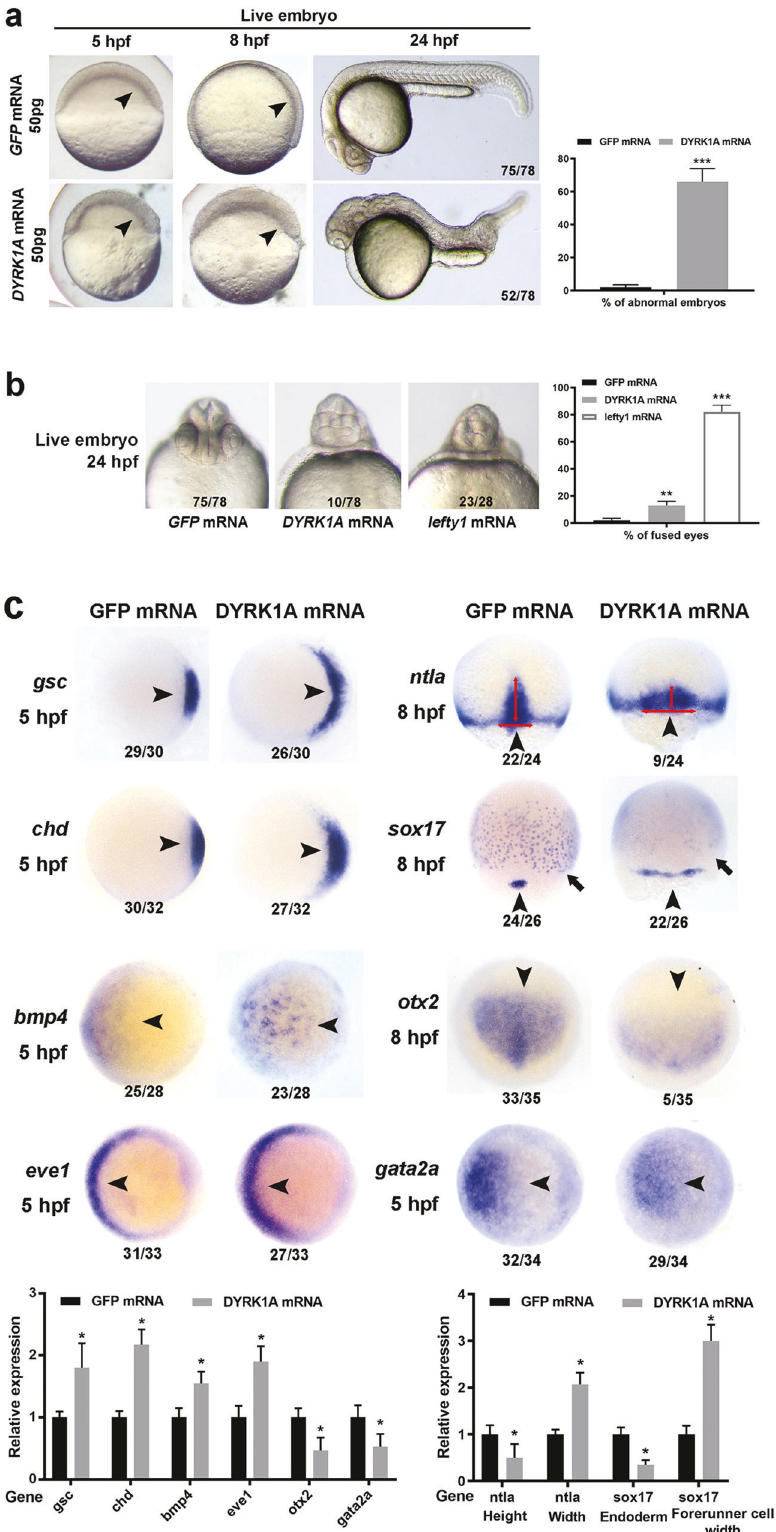
Fig. 1 DYRK1A-overexpressed zebra fi sh embryo model showed shortened/curved body axis. a Morphogenesis of live control (injection with GFP mRNA) and DYRK1A-overexpressed (injection with DYRK1A mRNA) embryos. The arrowheads indicate the dorsal side of the embryo. b Fusion of eyes caused by DYRK1A overexpression resembled the phenotype of lefty1 mRNA injection. c Germ layer marker expression detected by WISH during gastrulation. Orientation: ntla, sox17, and otx2, dorsal views with an animal pole to the top; others, animal-pole views with dorsal to the right. The numbers indicated in each picture are the number (left) of affected embryos with a phenotype similar to what is shown in the picture and the total number (right) of observed embryos. The same number labeling was used thereafter.